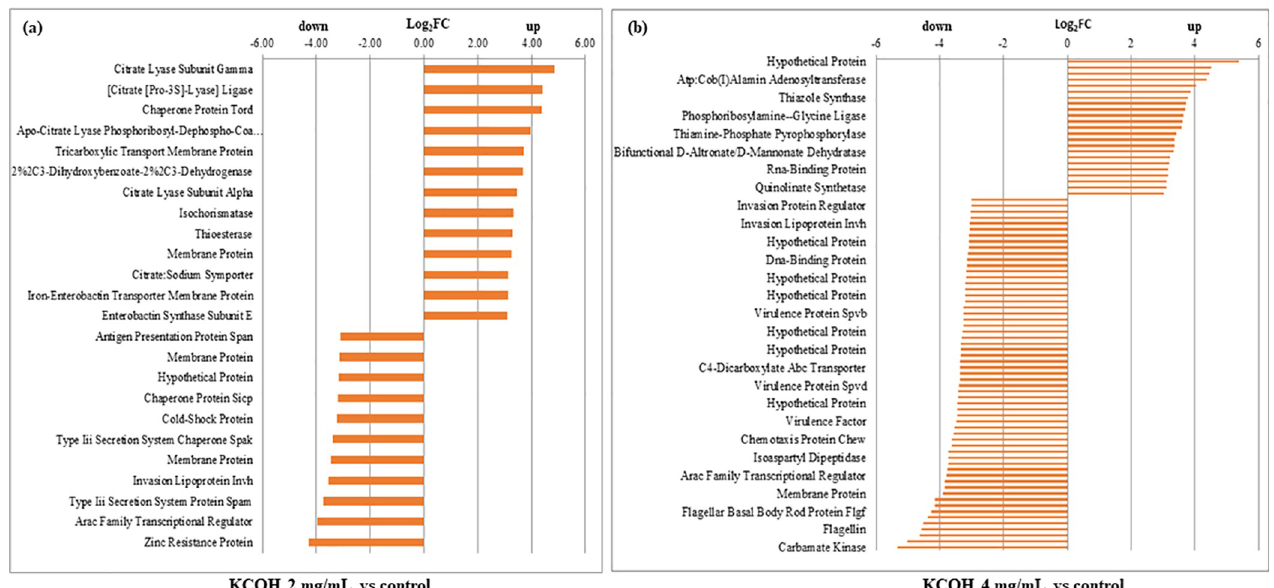
Fig 5. (a) Differentially Expressed Genes (DEGs) ( � 3 Log-Fold upregulated or downregulated genes) in S . Enteritidis ABBSB1004-1 at KCOH 2 mg/mL vs control; (b) Differentially Expressed Genes (DEGs) ( � 3 Log-Fold upregulated or downregulated genes) in S . Enteritidis ABBSB1004-1 at KCOH 4mg/mL vs control.